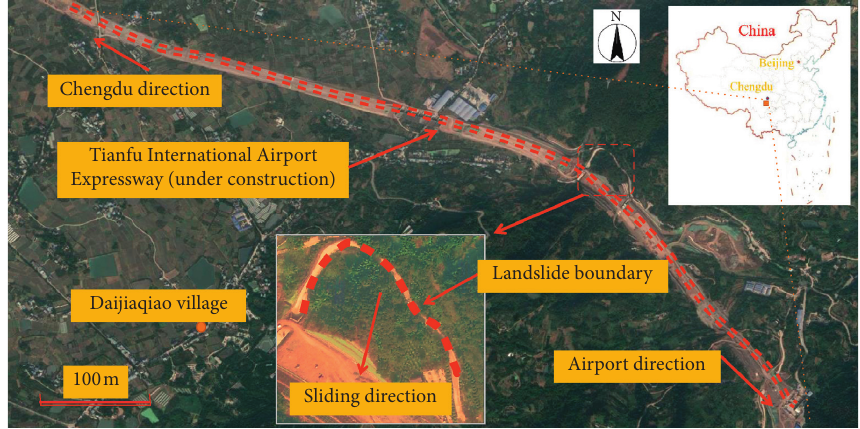
Figure 1: K17 +700 ～ K 17+900 landslide view.